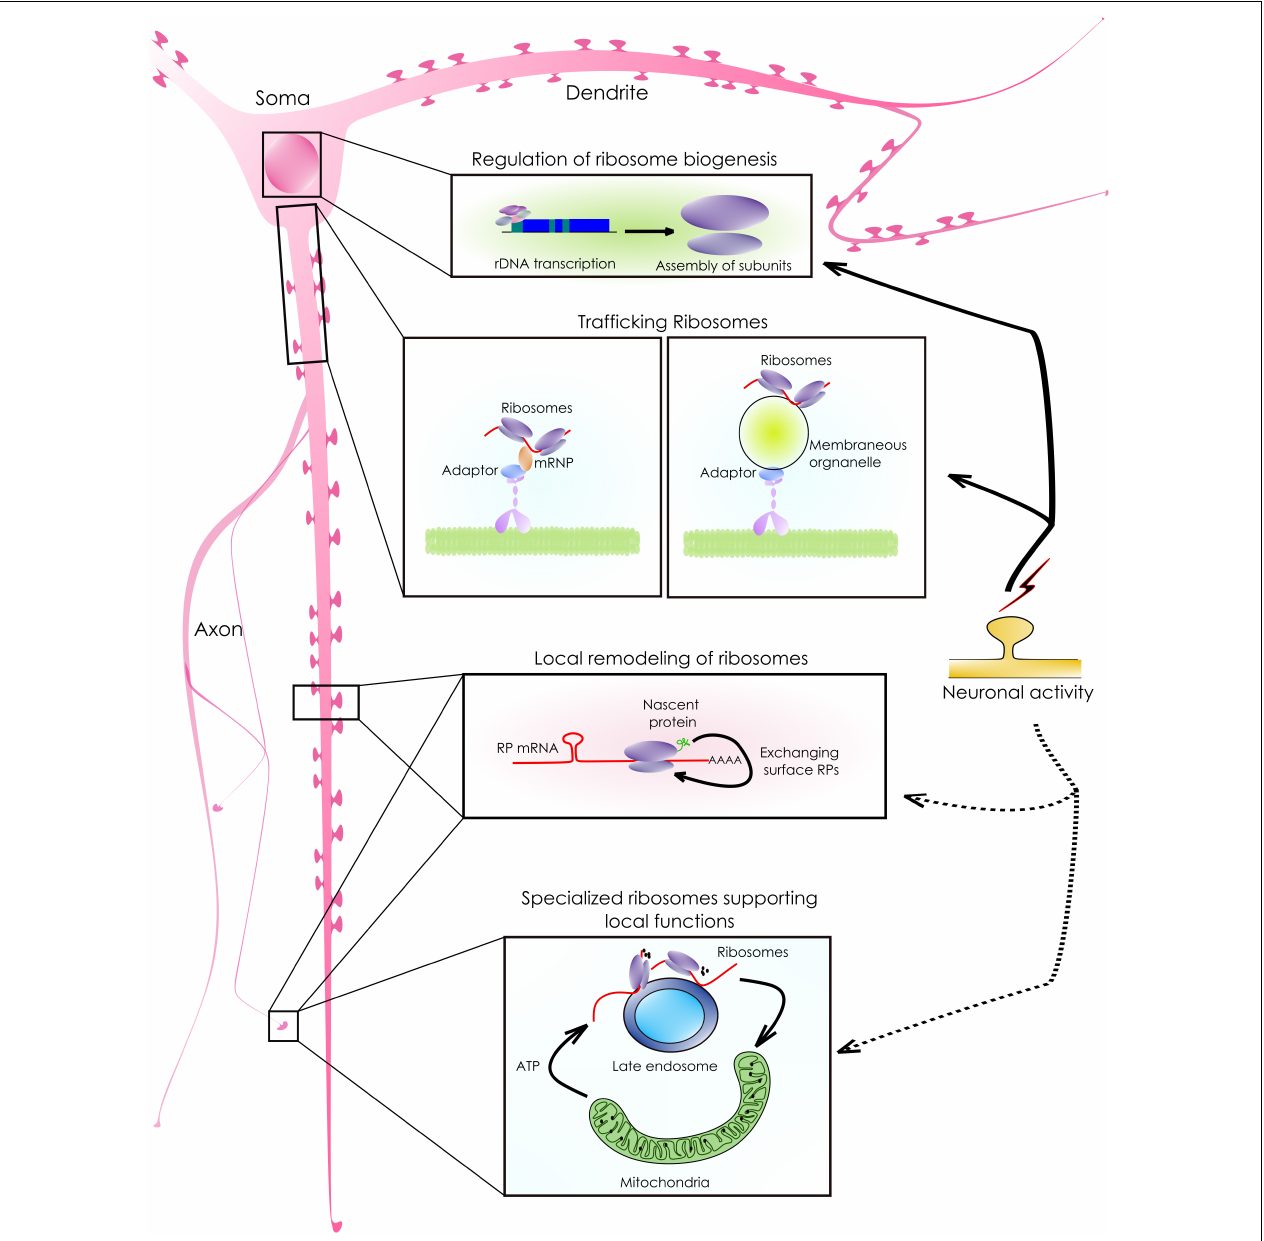
FIGURE 2 | Ribosomal synthesis, sorting, and remodeling to support local functions. As shown in the schematic, neurons have an arborized morphology. mRNA abundant. As a result, the availability of ribosomes and translation machinery in these remote locations is crucial for the abundant local mRNA translation that supports neuronal functions. Following biosynthesis, ribosomal sorting in neurons happens either via diffusion or by active transport. The active sorting, is achieved either by associating with mRNPs or by tethering to membrane-bound organelles targeted to distant locations. In addition, existing ribosomes can exchange locally synthesized surface proteins (RPs) giving rise to ribosomes with specialized functions. For example, RP mRNAs with a specific sequence motif are translated into the axons which, can then associate with the surface components of existing ribosomes. Such modifications allow ribosomes to translate a distinct set of transcripts that support local